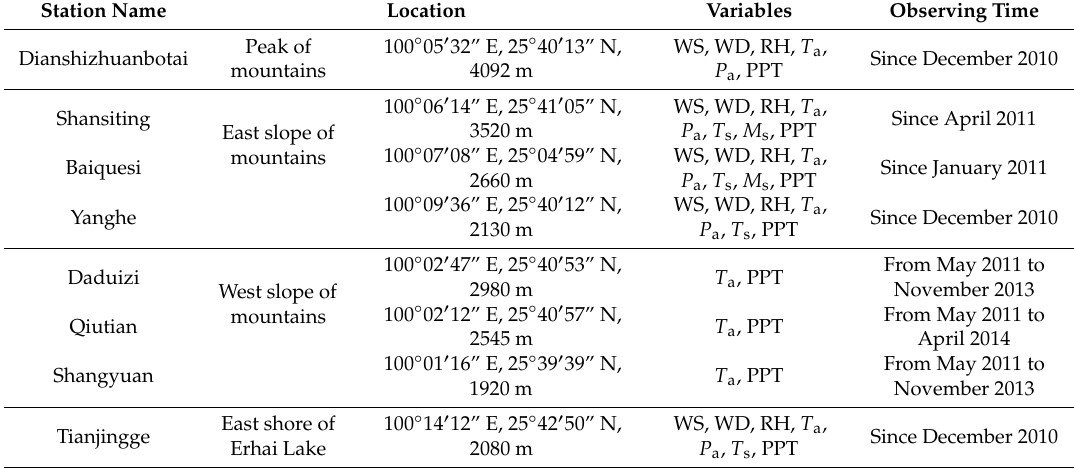
Table 1. Basic characteristics of the sites for typical profile observations of mountain meteorology, where measured variables including wind speed (WS), wind direction (WD), relative humidity (RH), air temperature ( T a ), air pressure ( P a ), soil temperature ( T s ) at depths of 0, 10, 15, and 20 cm, soil moisture profile ( M s ) at depths of 5, 10, and 20 cm, and precipitation (PPT), but variables of each site are di ff